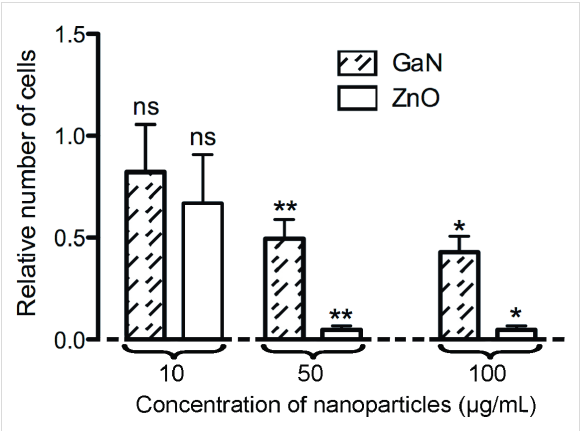
Figure 2: Relative number of endothelial cells after 3 days of incuba- tion with 10 µg/mL, 50 µg/mL, or 100 µg/mL GaN or ZnO nanoparti- cles compared to untreated cells. Values are expressed as mean ± standard deviation of 3 independent experiments with 3 replicates. ns: nonsignificant, * p < 0.05, ** p < 0.01.